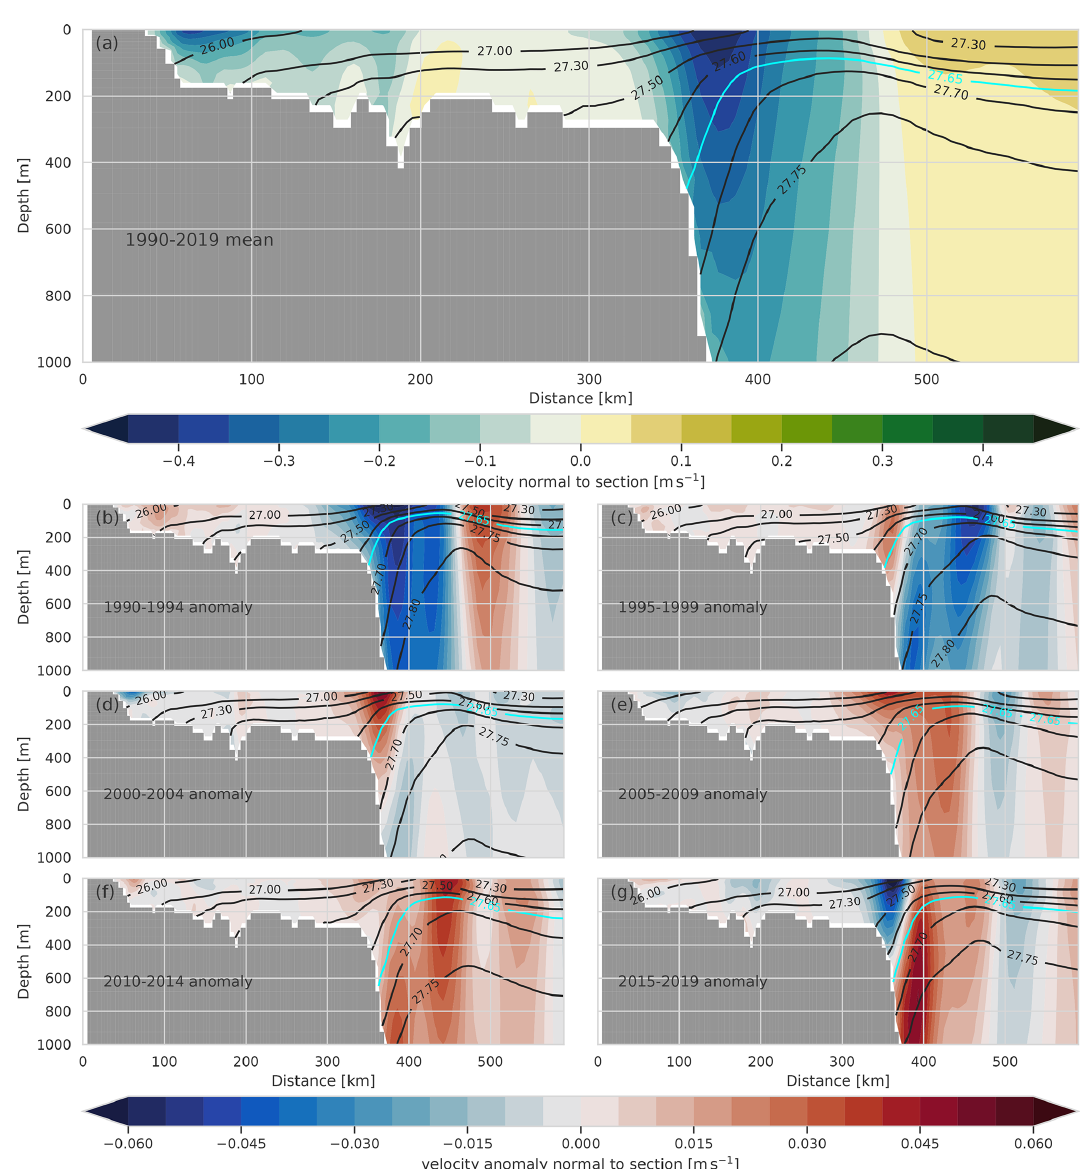
Figure 11. Vertical sections of Labrador Sea upper-layer outflow 1990–2019 mean velocity (a) and pentadal velocity anomalies from the mean (b) – (g) , with period-mean density contours superimposed, at the western end of the OSNAP line. Velocities, and velocity anomalies, are shown as positive into the Labrador Sea. Lighter waters ( < 27 . 65kgm − 3 ) leaving the Labrador Sea are mostly transported to OSNAP E in the subpolar gyre; this transport is dominated by strong currents at the shelf break. Outward currents in the lighter density classes are weaker (positive – red – anomalies) than the 30-year average between 2000 and 2015 (d–f) . The increasing contribution of Labrador Sea origin waters to eastern SPG transports in the 2010s is associated with the deepening of these lighter layers rather than increasing currents; notice the highlighted 27.65kgm − 3 isopycnal in (b) – (g)